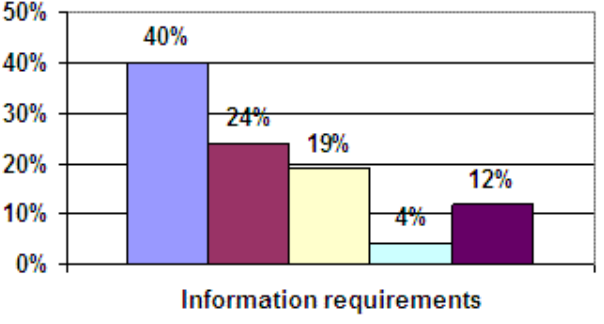
Figure 5 Proportional contribution of information requirements per information